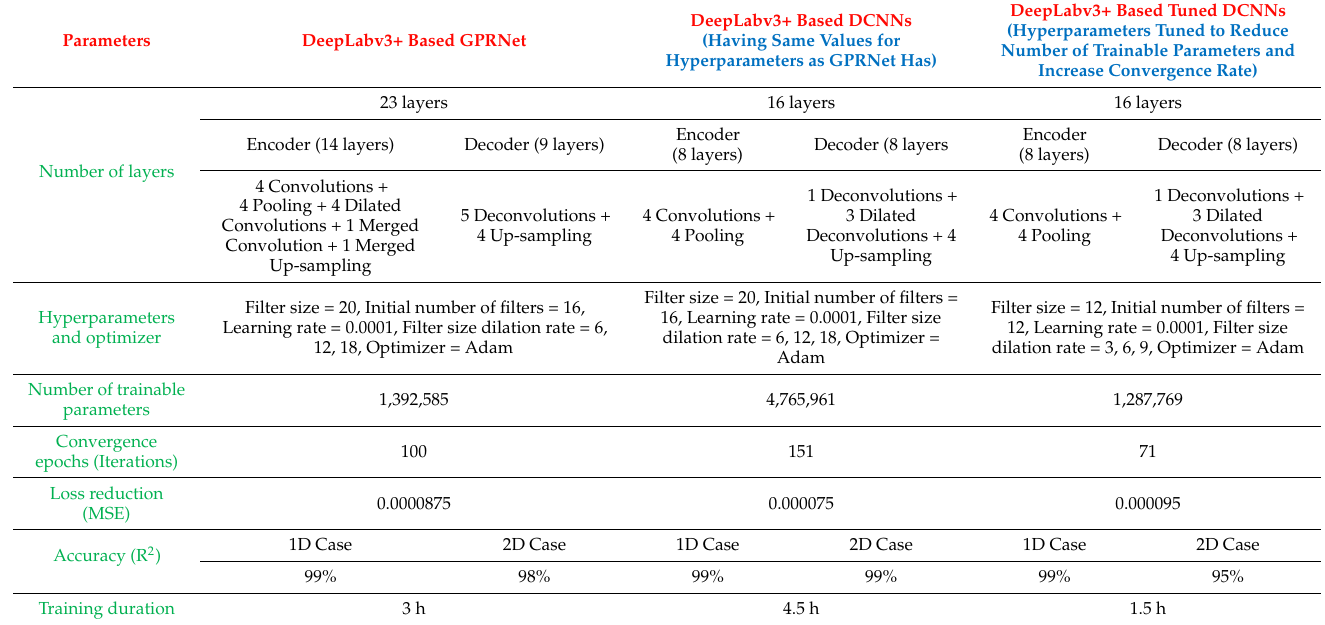
Table 1. Comparison between existing DeepLabv3+ based networks (GPRNet) and our two versions of DCNNs. The parameters considered for comparison are the number of layers, hyperparameters and optimizer, number of trainable parameters, convergence epochs, loss reduction, accuracy, and training